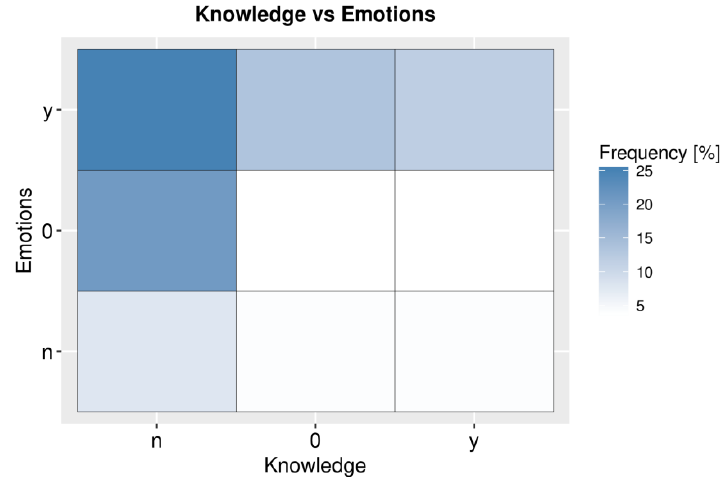
Figure 3. Frequency of responses compared between the knowledge and emotions dimensions—all users. ISPRS Int. J. Geo-Inf. 2018 , 7 , x FOR PEER REVIEW